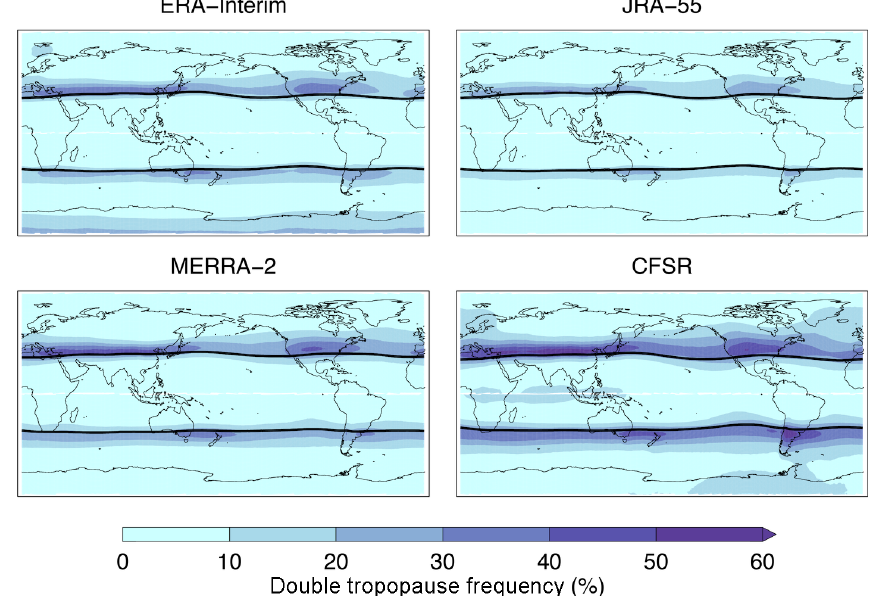
Figure 8. As in Fig. 6, but for reanalyses only in a coordinate relative to the tropopause break.